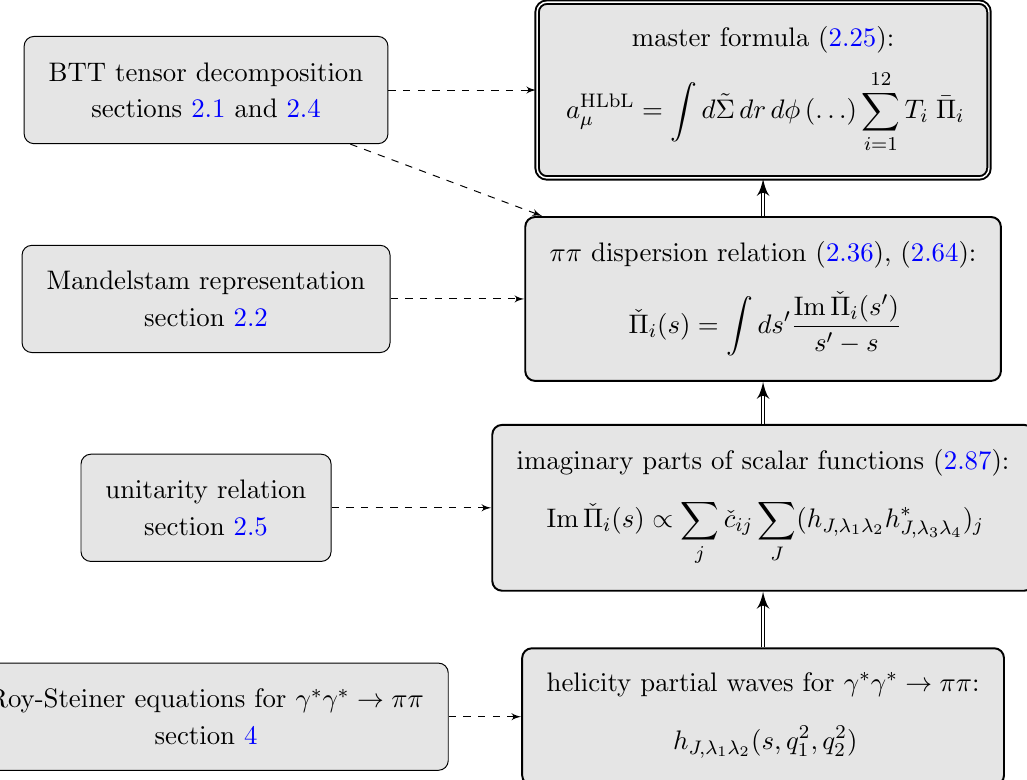
Figure 2. Outline of the formalism for the HLbL two-pion contribution to ( g lines denote a derivation or calculation, the double lines indicate the insertion of